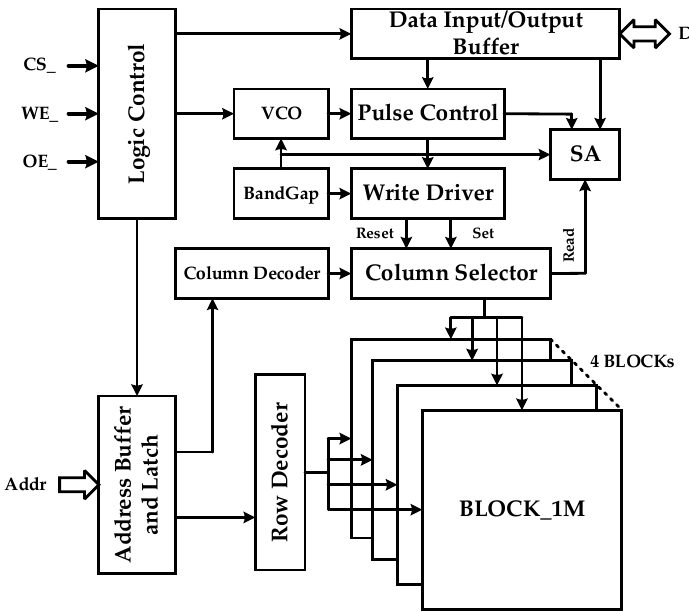
Micromachines 2019 , 10 , x Figure 5. The architecture framework of the 4 M 2-bit / cell phase change memory chip. Figure 5. The architecture framework of the 4 M 2-bit/cell phase change memory chip.